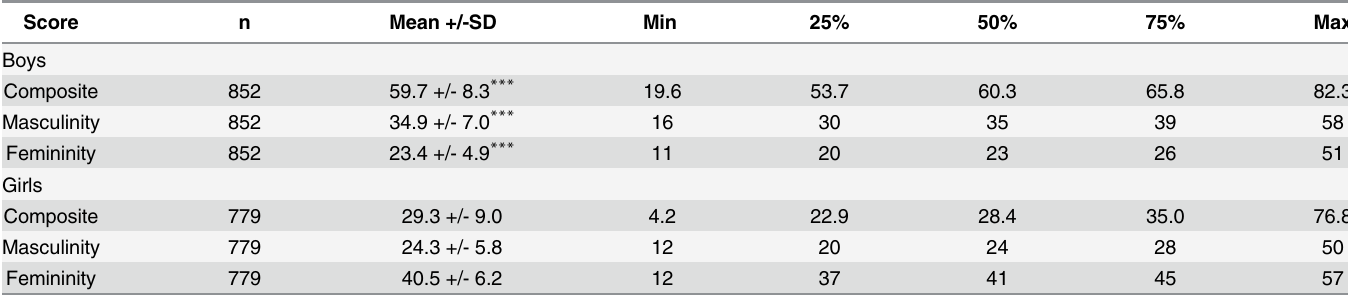
PSAI Composite, masculine, and feminine scores in PSAI were shown in Table 3 for boys and girls. Composite scores in PSAI were significantly higher in boys than in girls (p < 0.0001). While masculine scores were significantly higher in boys than in girls, feminine scores were signifi- cantly lower in boys. Table 3. Summary of